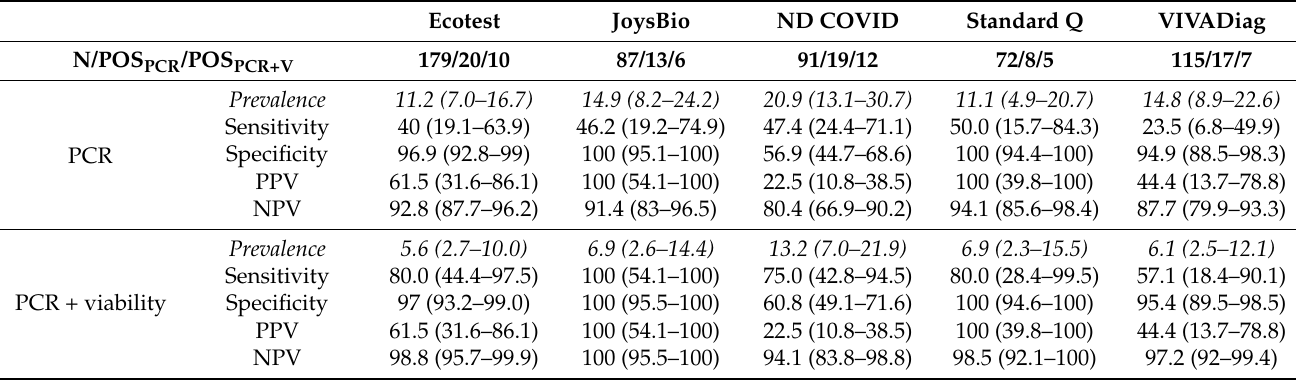
Table 5. Test parameters for individual ATGs for a subgroup of asymptomatic patients (estimates and 95% confidence inter-